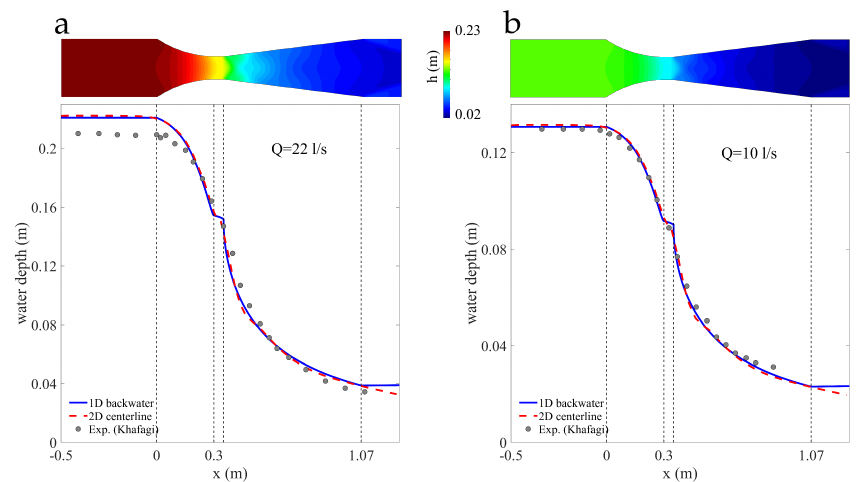
Figure 10. Model validation: transcritical flow in a Khafagi flume. Comparison between experimental observations of water surface profile [24] and model predictions, for discharges of Q = 22 L/s ( a ) and Q = 10 L/s ( b ). We consider a channel that is short enough for the hydraulic jump to be repelled out of the simulated domain.